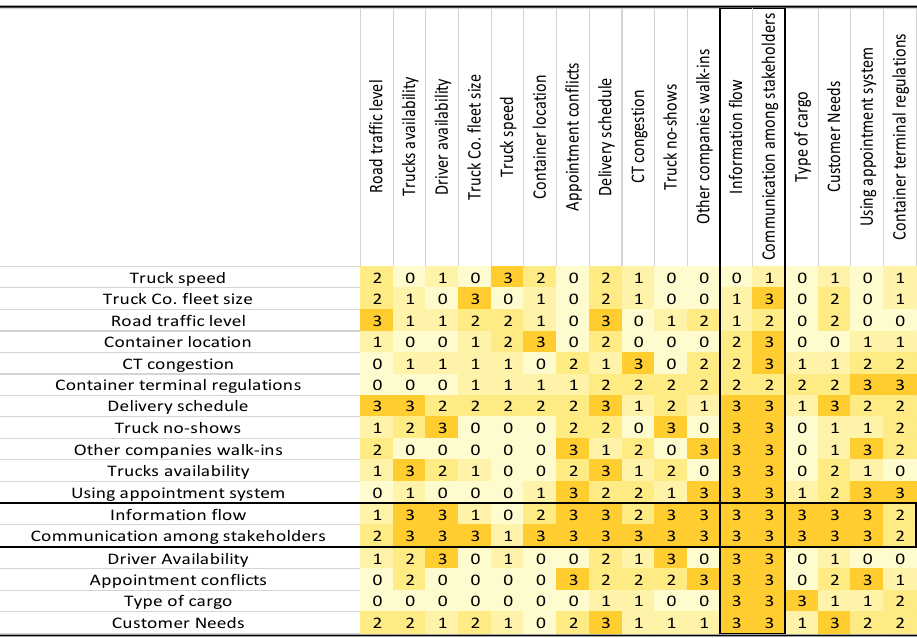
Figure 3. Insight matrix before sorting based on the strength of the correlation between the factors.